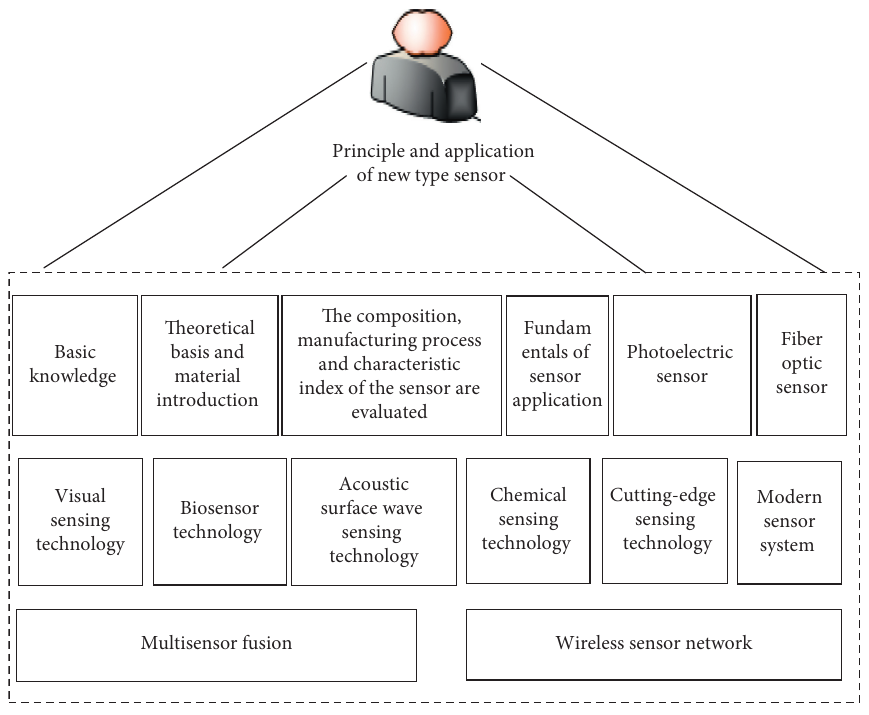
Figure 5: Course content diagram of new sensor principle and